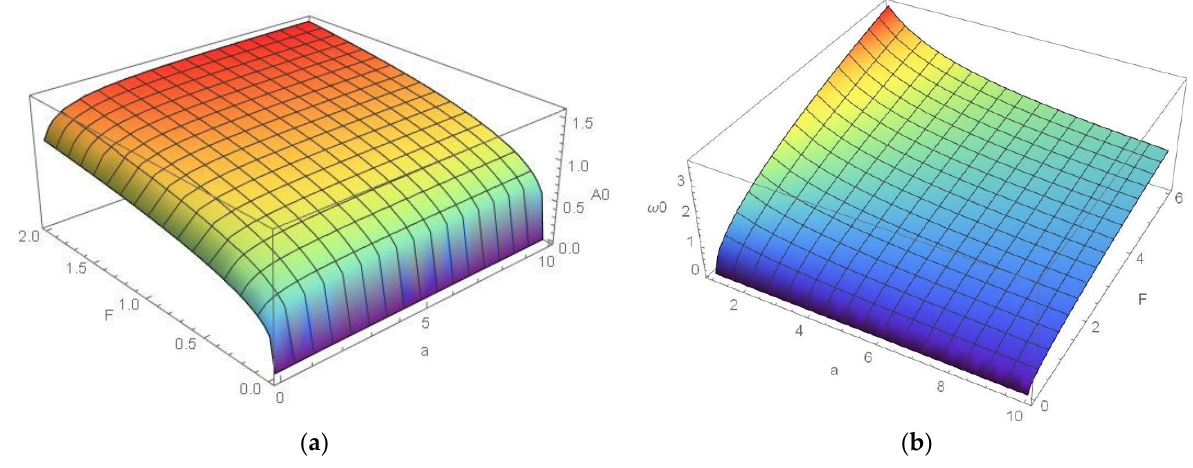
Figure 4. ( a ) A 0 - F - a and ( b ) ω 0 - F - a diagrams for constant α , k , b . In Figure 5, the influence of mass variation parameter and rigidity coefficient on the amplitude (a) and frequency (b) of vibration is considered. Namely, the A 0 - k - a (Figure 5a) and ω 0 - k - a (Figure 5b) diagrams are plotted for constant α = 3, F = 1N and a/b = 0–20. The amplitude varies in the interval A 0 = (0–3) mm, the frequency ω 0 = (0–4) s − 1 and k = (0–2) N/mm 4 . It is shown that the amplitude of vibration decreases with k : if the added mass is larger, the amplitude of vibration is higher and decreases slower than for small added mass. However, it is seen that the amplitude of vibration is almost constant in the interval a = (1–10) kg/mm for k = (1–2) N/mm 4 . In addition, the frequency of vibration is almost constant for a = (5–10) kg/mm and k = (0.5–2) N/mm 4 . For small added mass the influence of k on the frequency is more significant than for a large mass quantity.